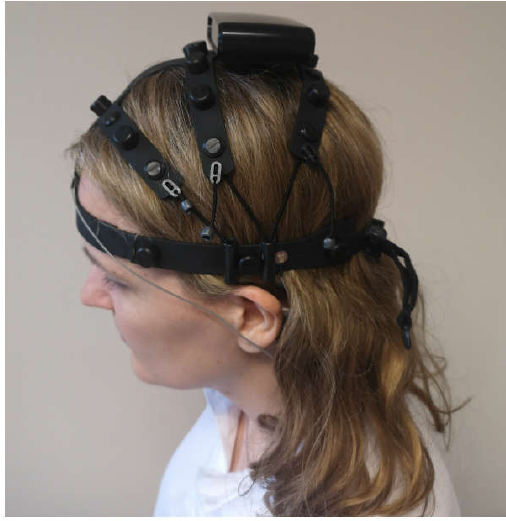
Figure A2. Option 2: EEG Home-Monitoring.